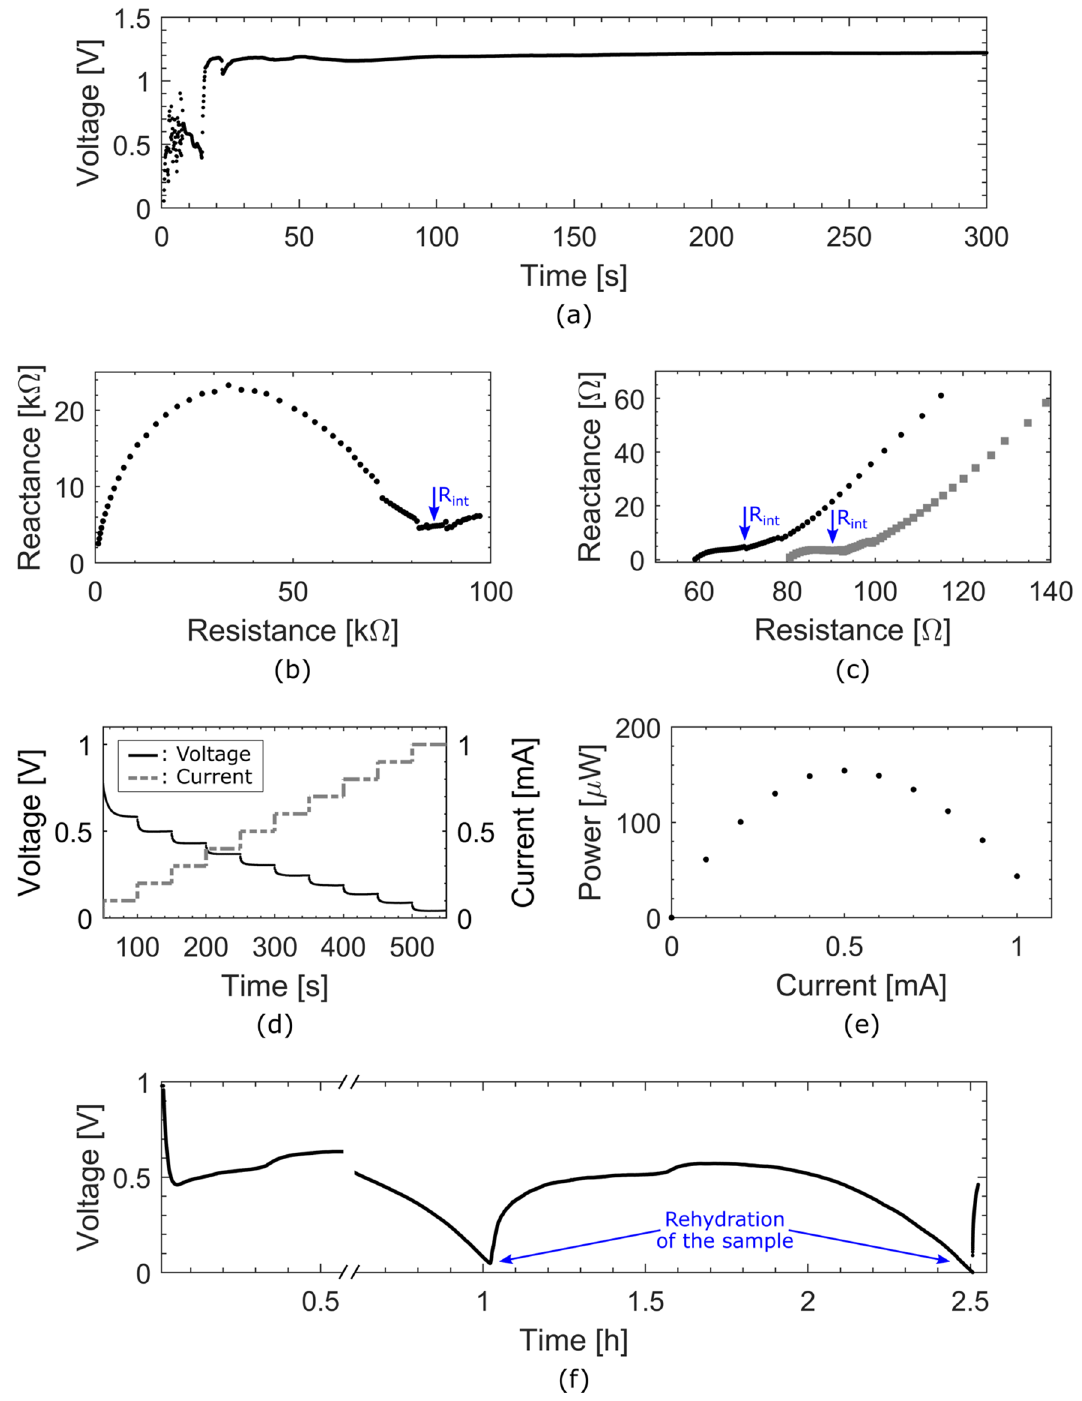
Figure 3. ( a ) Graph of the open circuit potential (OCP) of the single-cell battery as a function of time upon activation. Time zero corresponds to the moment water was dispensed on the activation wick. The battery shows a stable 1.2 V OCP and a 20 s activation time. ( b ) Nyquist plot of the battery before activation, showing an internal resistance R int of 85 kΩ. ( c ) Nyquist plots of the battery immediately upon activation (grey squares) and after 1 h of discharge at 100 μA (black dots), showing internal resistances R int of around 70 Ω and 90 Ω, respectively. ( d ) Chronopotentiogram of the battery (black solid line) and the corresponding current ramp (grey dotted line) as a function of time. ( e ) Graph of the power generated by the battery as a function of the current, showing a maximum of 150 μW at 0.5 mA. ( f ) Chronopotentiogram of the battery at a constant current of 100 μA, showing the process of drying and reactivating the device. The discontinuity in the data points is due to complementary analysis that were carried out on the sample at its peak operating